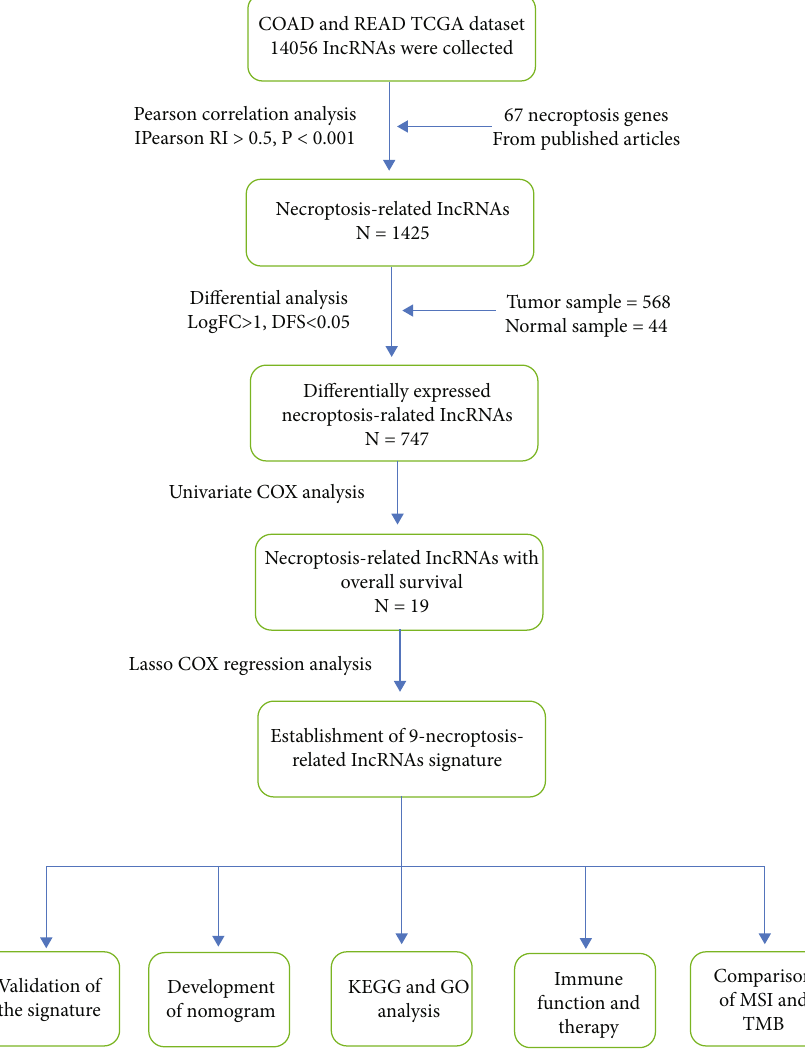
Figure 1: The main analysis process of this